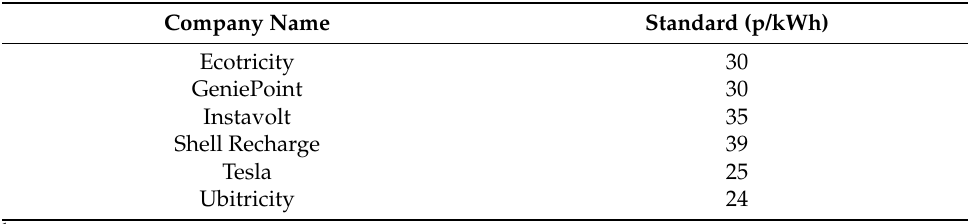
Table 2. Example of UK public pricing 1